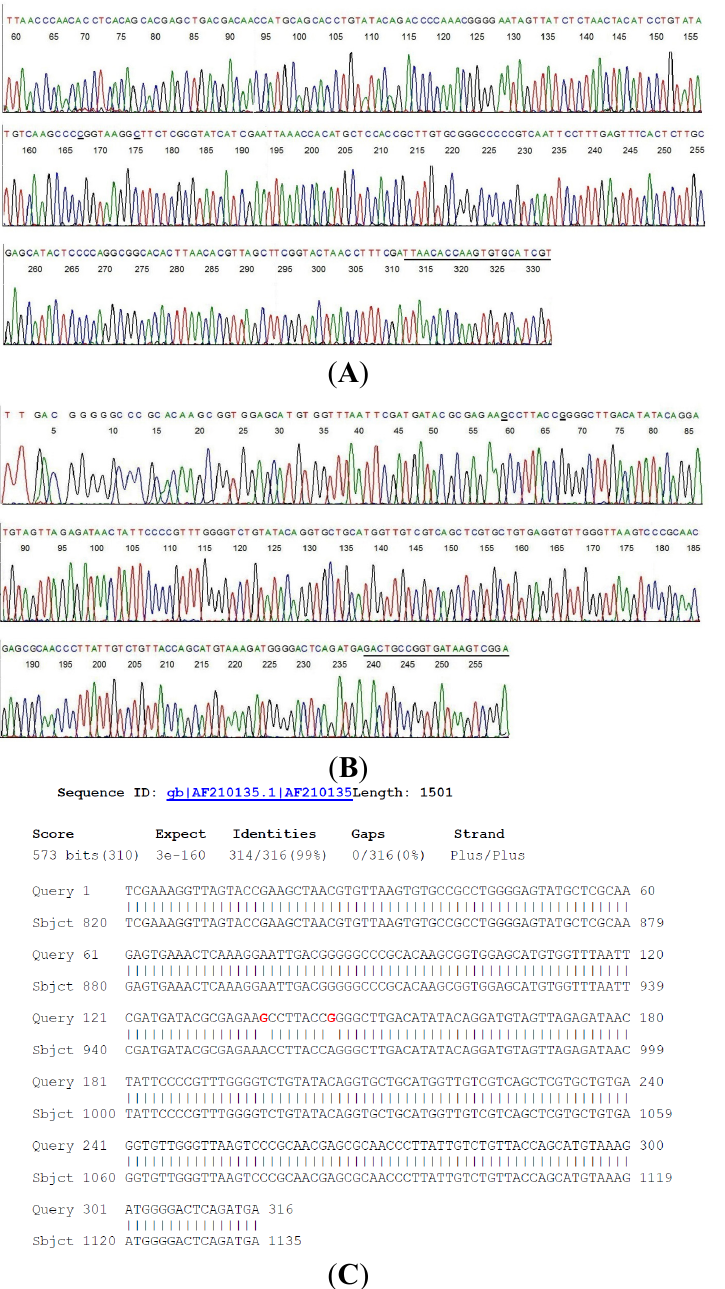
Figure 1. Two-directional sequencing of a highly conserved 358-bp 16S rDNA segment with hypervariable regions of bacterial residues in a human serum sample obtained from a patient diagnosed with “neurologic Lyme disease” (Table 1, #9). ( A ) M2 was the sequencing primer and the M1 primer-binding site is underlined; ( B ) M1 was the sequencing primer and the M2 primer-binding site is underlined; ( C ) Borrelia coriaceae isolate CA434 16S ribosomal RNA gene, partial